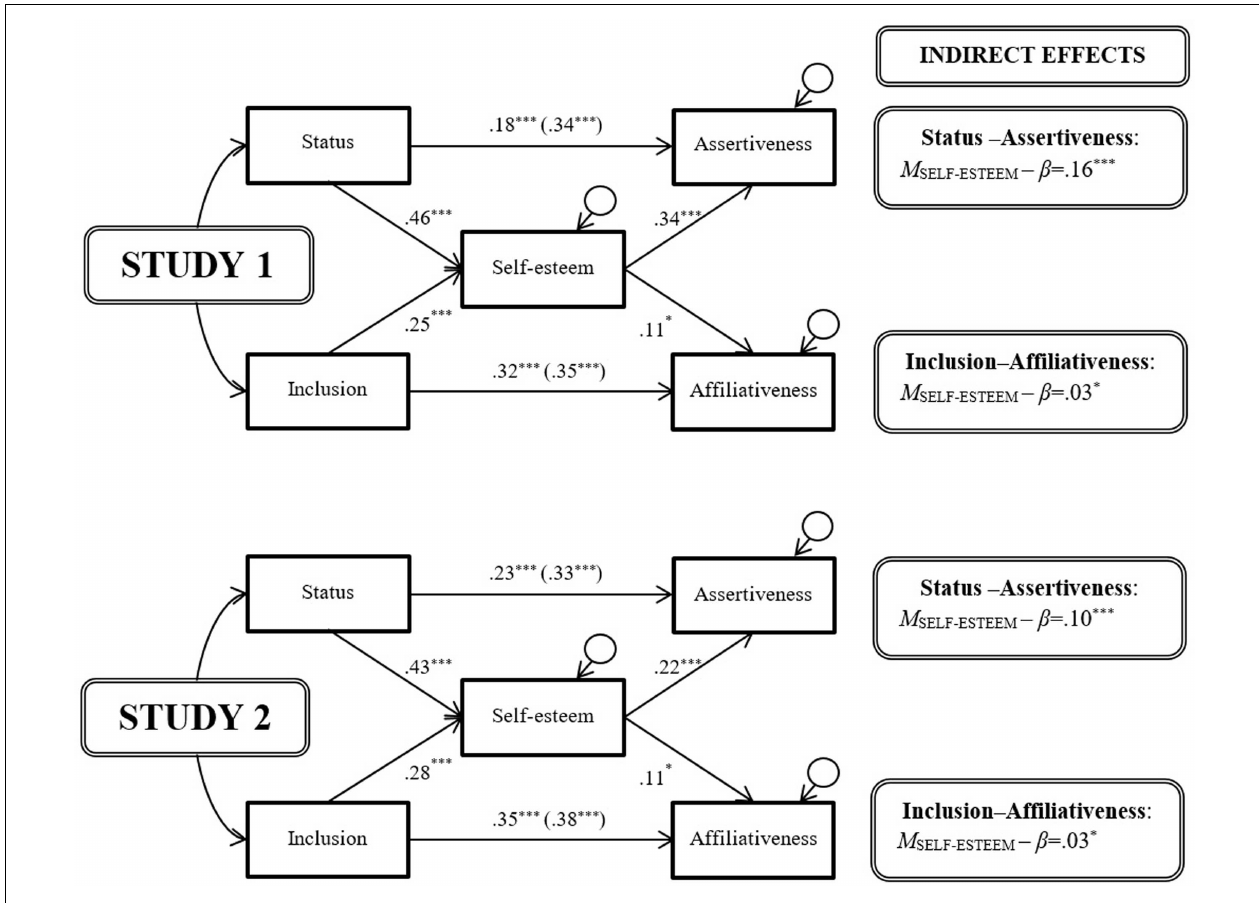
FIGURE 2 | The mediating effect of self-esteem. † p < 0.10; ∗ p < 0.05; ∗∗ p < 0.01; ∗∗∗ p <